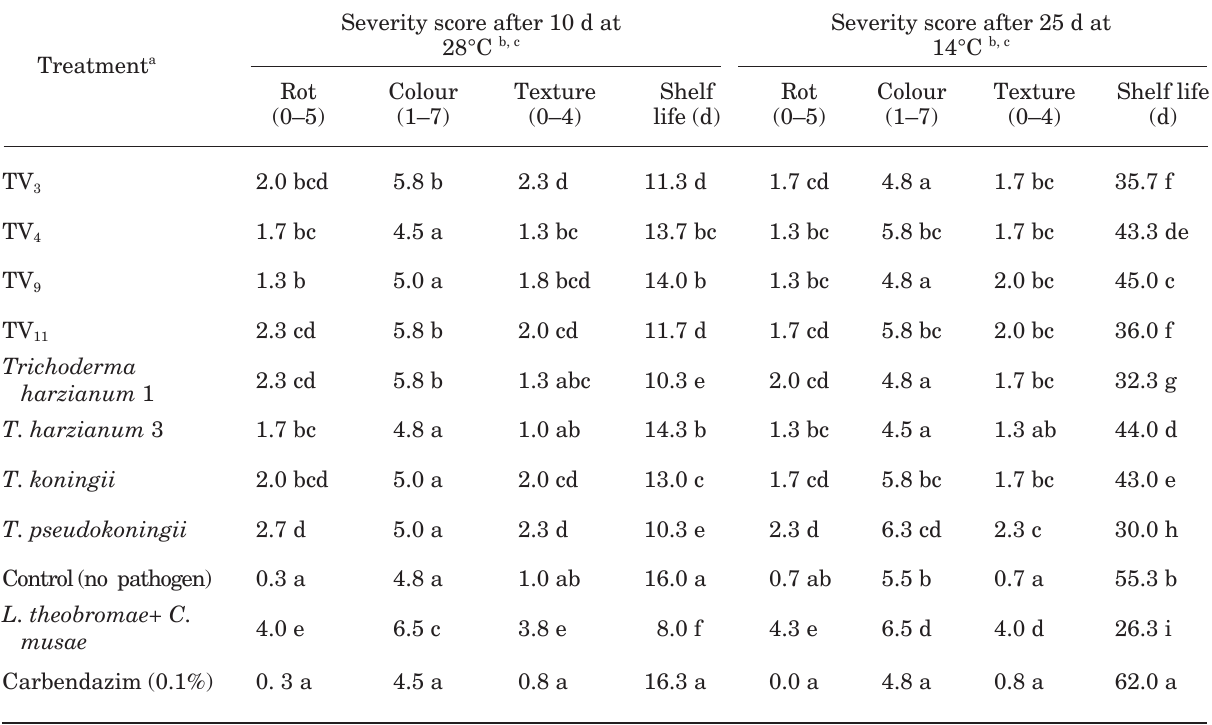
Table 4. Mean crown rot severity, colour and texture scores, and mean shelf life, for banana fruit cv. Robusta sprayed with different Trichoderma spp.